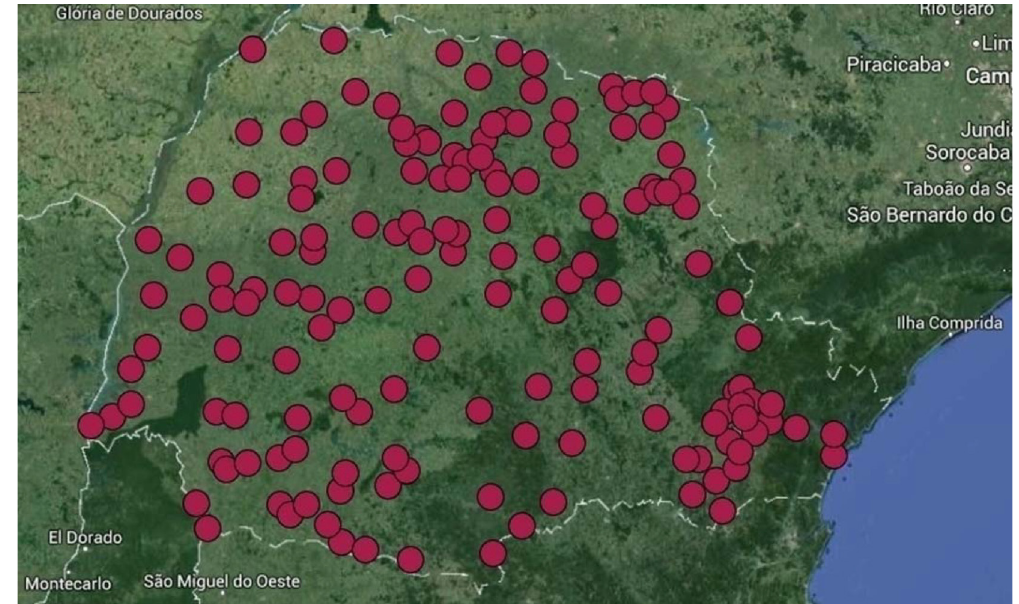
FIGURE 1 - Distribution of respondents in the State of